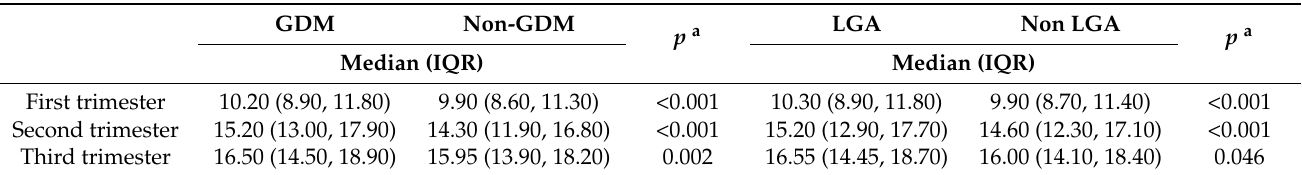
Table 4. The association between vitamin E concentration (continuous variable) and GDM and large for gestational age (LGA), by univariate